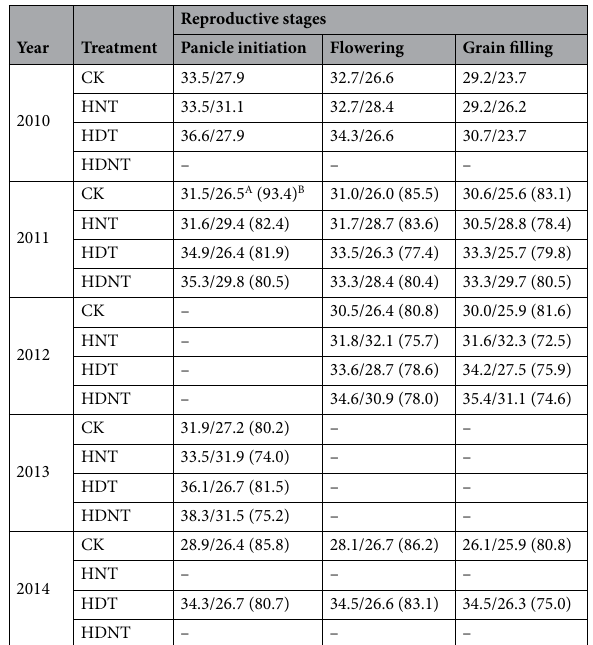
Table 1. Average temperatures (daytime/nighttime, °C) and average relative humidity (%) in the greenhouse from 2010–2014. HNT, high nighttime temperature treatment; HDT, high daytime temperature treatment; HDNT, high daytime and nighttime temperature treatment; CK, control. A, average temperature records of daytime and nighttime during the five experimental years; B, values in the brackets were average relative humidity during the whole